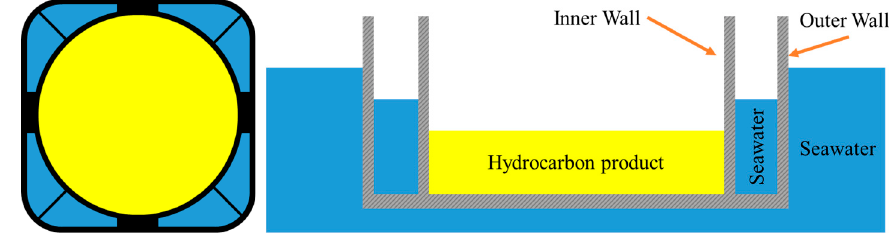
Figure 25. Plan and side view of tank with sea water between double hulls.